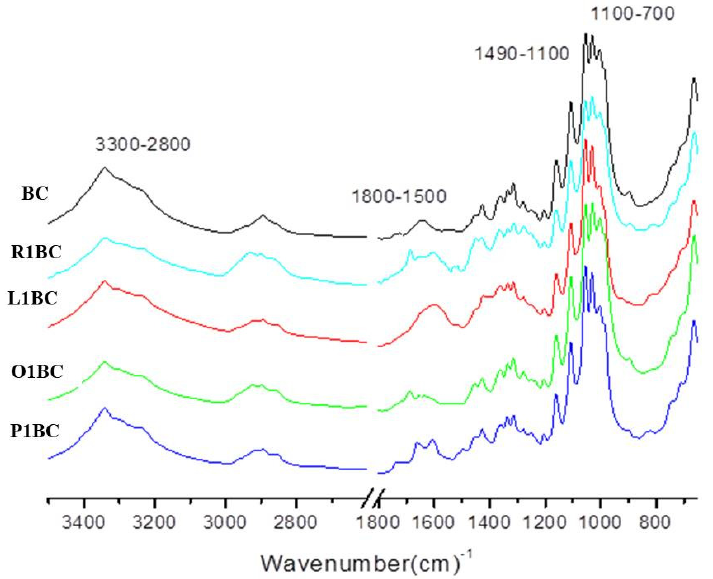
Figure 6. FT-IR spectra of bacterial cellulose (BC) and bacterial cellulose incorporated with rosemary extract (R1BC), lovage extract (L1BC), oregano extract (O1BC), and parsley extract (P1BC).